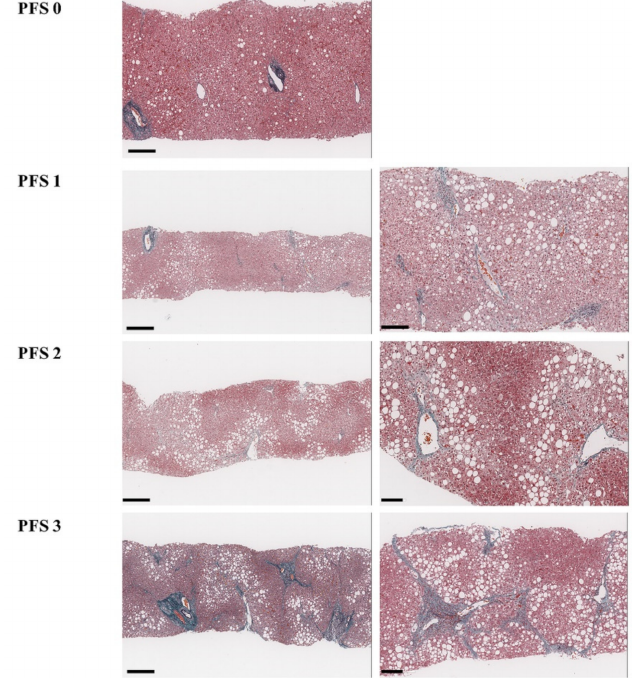
Figure 3. Histopathological definitions of PFS. PFS 0, no liver fibrosis, and the small bars represent 200 µ m. PFS 1, pericellular fibrosis confined to the proximity of central veins and is present in approximately <50% of these veins; high-power field view (right). Small bars represent 300 µ m and 100 µ m (from the left). PFS 2, pericellular fibrosis confined to the proximity of central veins and is present in >50% of the central veins; high-power field view (right). Small bars represent 200 µ m and 100 µ m (from the left). PFS 3, pericellular fibrosis around the central veins with periportal fibrosis or bridging fibrosis; high-power field view (right). Small bars represent 200 µ m and 100 µ m (from the